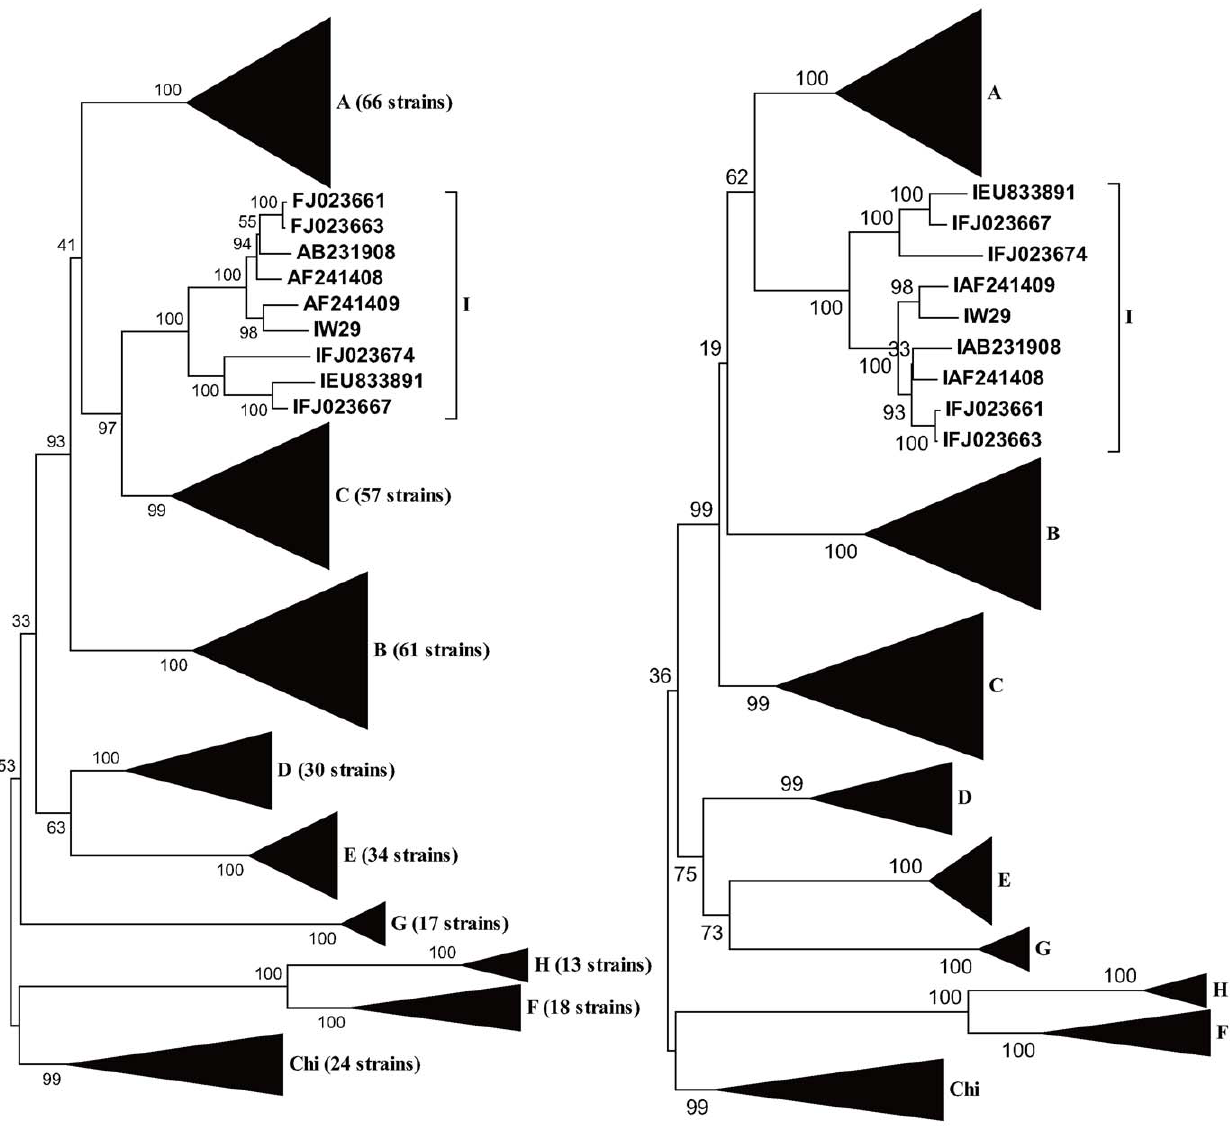
Figure 1. Phylogenetic analysis of complete genomes (left) and P gene products (right). The sequences include all the reference sequences, representative Vietnam and Laos’ sequence and W29 strains. The putative genotype I strains are separated as an independent clade. Sequences of Genotype A-H have been collapsed into black triangles.